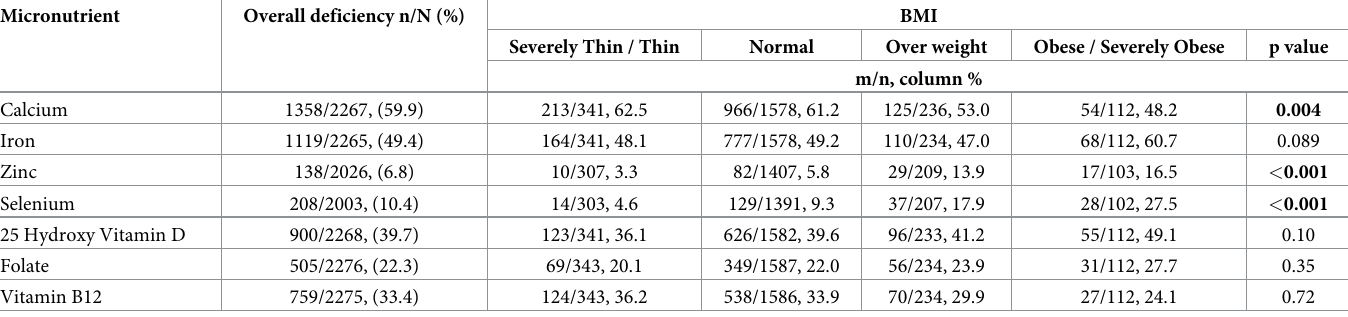
Table 4. Comparison of micronutrient deficiency in participants across BMI categories.